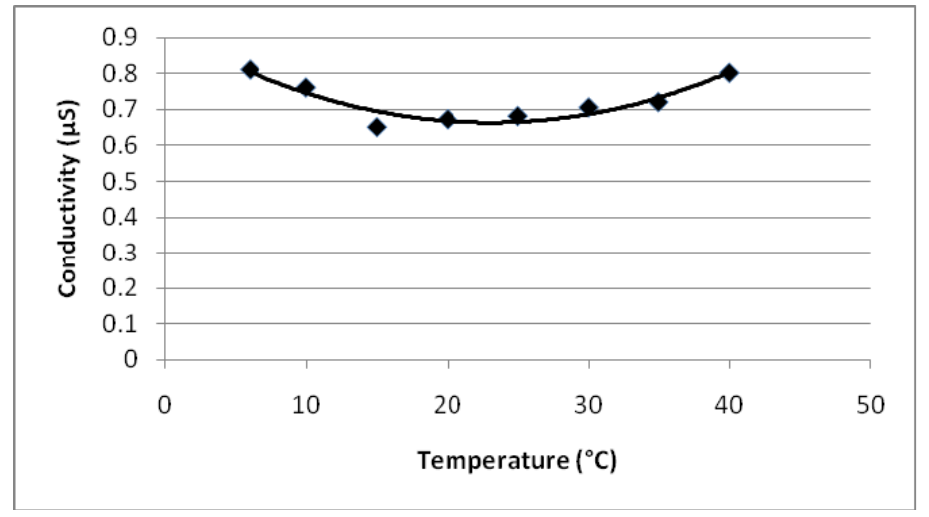
Figure 17. Conductivity vs. temperature change of copolymer (II) without